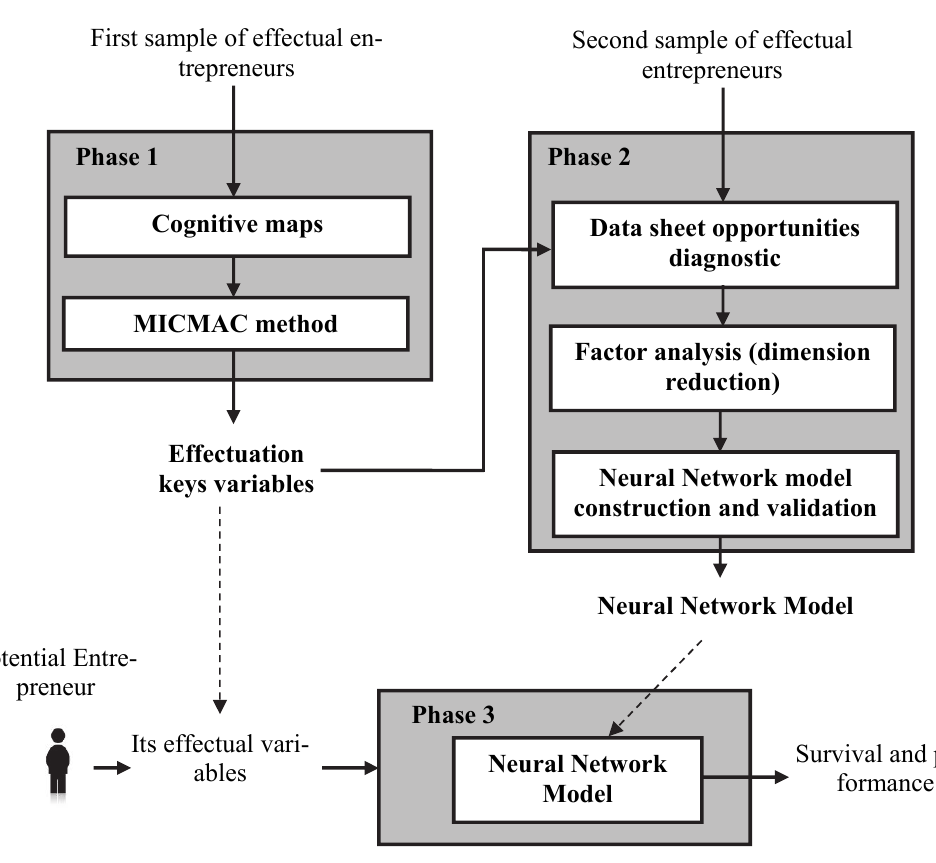
Fig. 3. Flow chart of the proposed approach